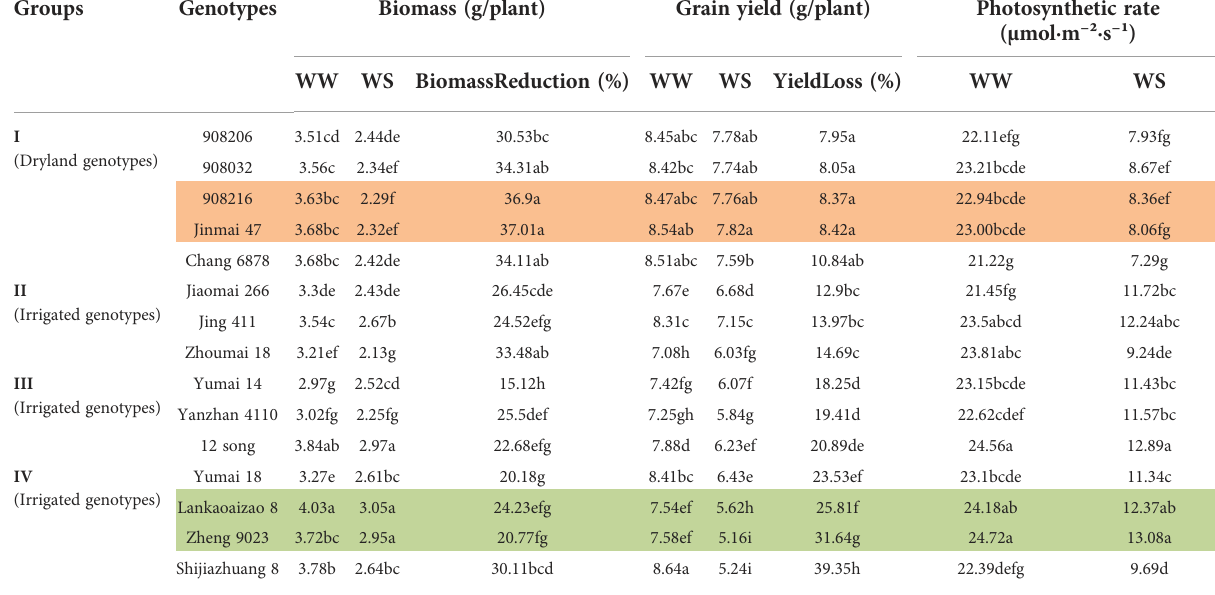
TABLE 1 Groups Genotypes Biomass (g/plant) Grain yield (g/plant)